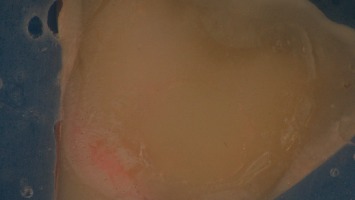
Observation of the bonding surface after rupture.